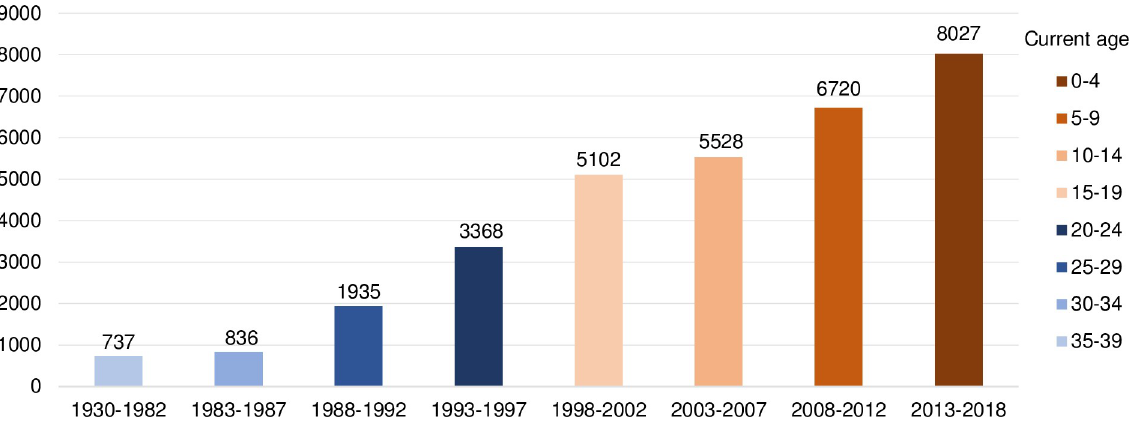
Fig 3. Number of second-generation girls and women by year of birth and current